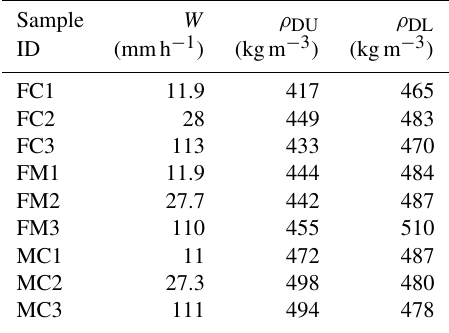
Table 1. Experimental conditions following Avanzi et al. (2016).